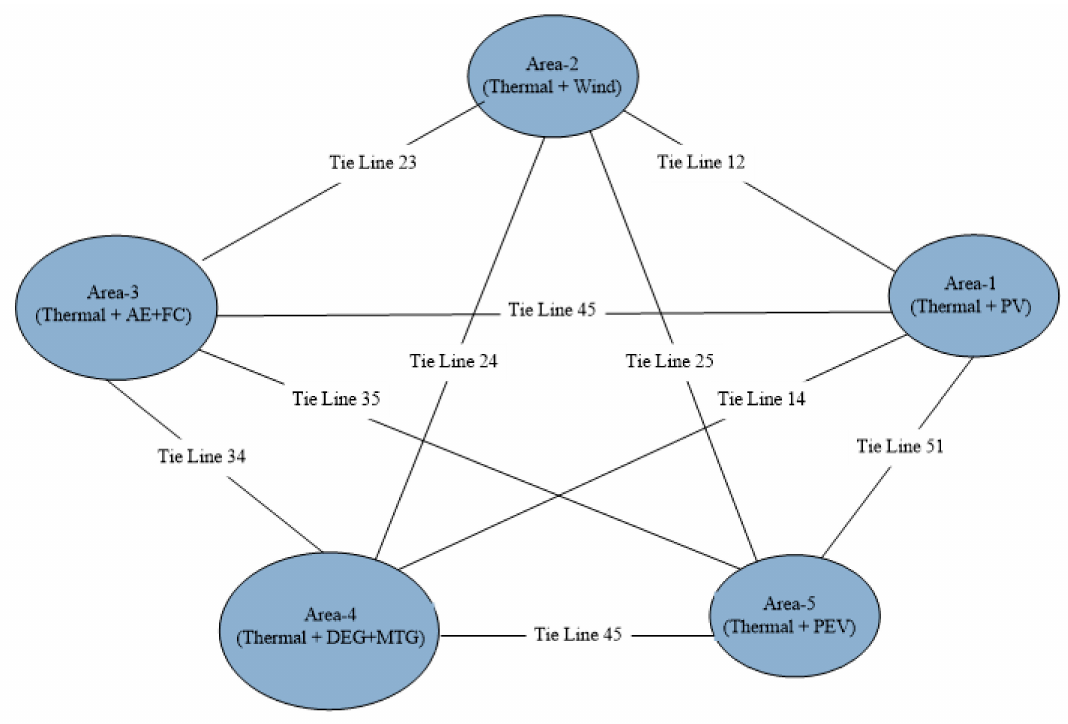
Figure 2. Proposed structure of a five-area hybrid power